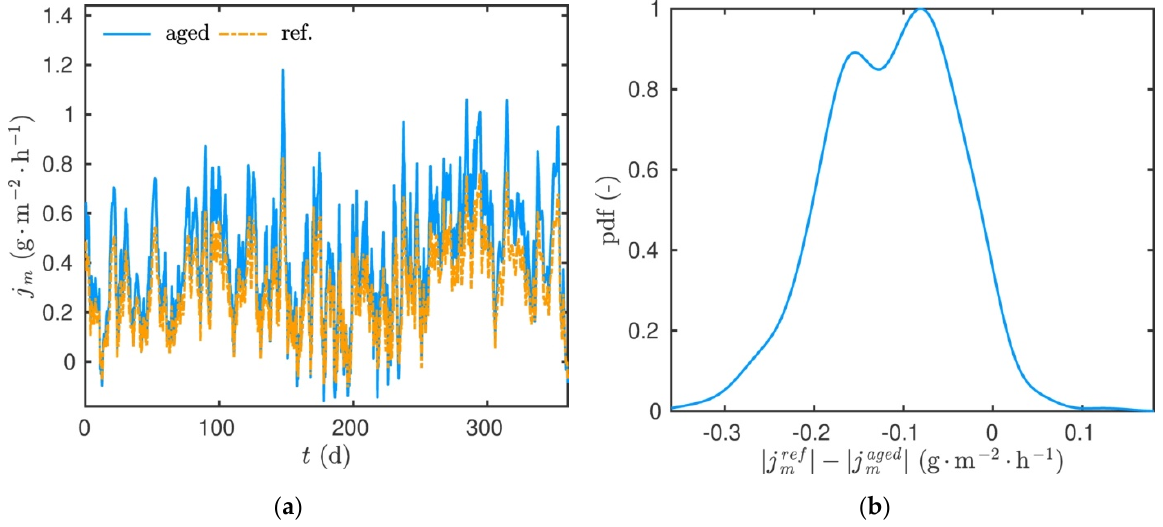
Figure 19. ( a ) Time evolution of the moisture flux and ( b ) density function of the difference of moisture flux between both configurations.